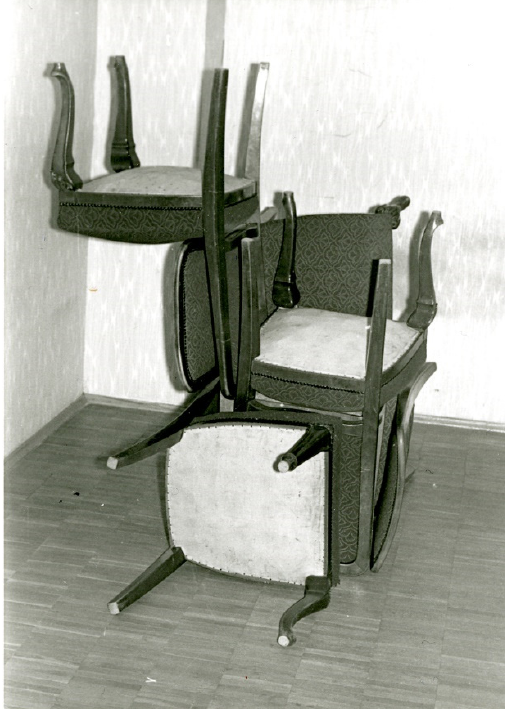
Figure 10. Skersis. Chair Wrapped in Chairs . 1979. Wooden chairs, black-and-white photograph. Courtesy of the artist.